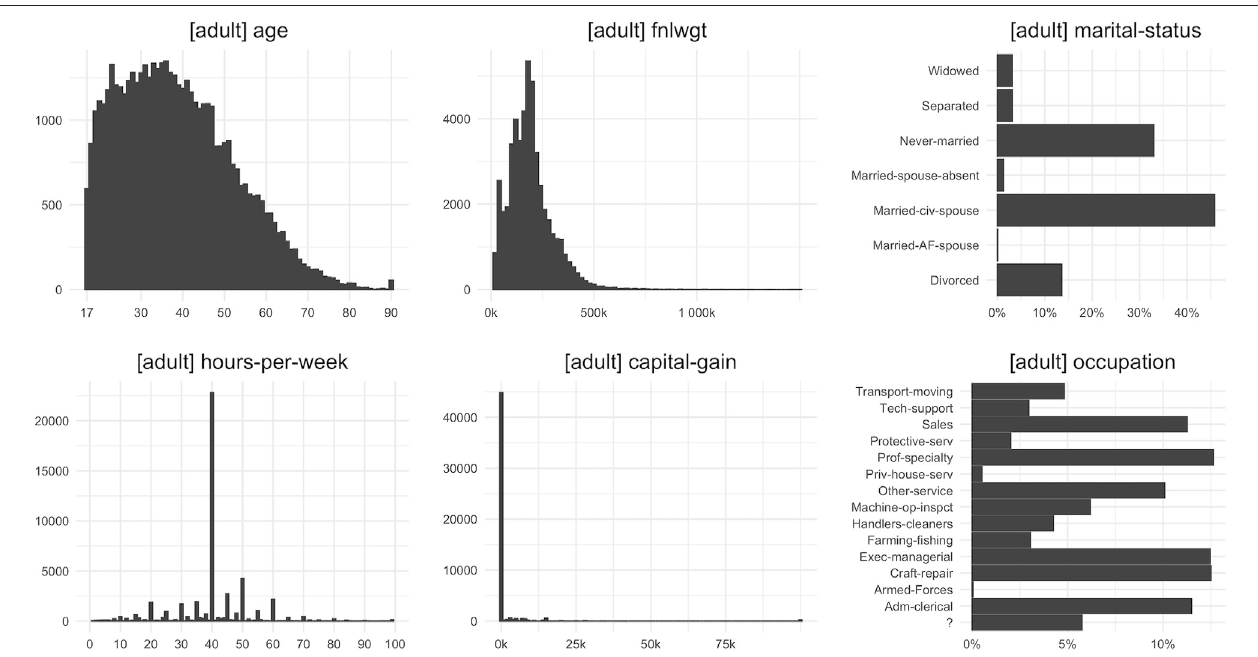
FIGURE 3 | Selected univariate marginal distributions for dataset “ adult ” demonstrating the broad spectrum of distributional patterns encountered in real-world